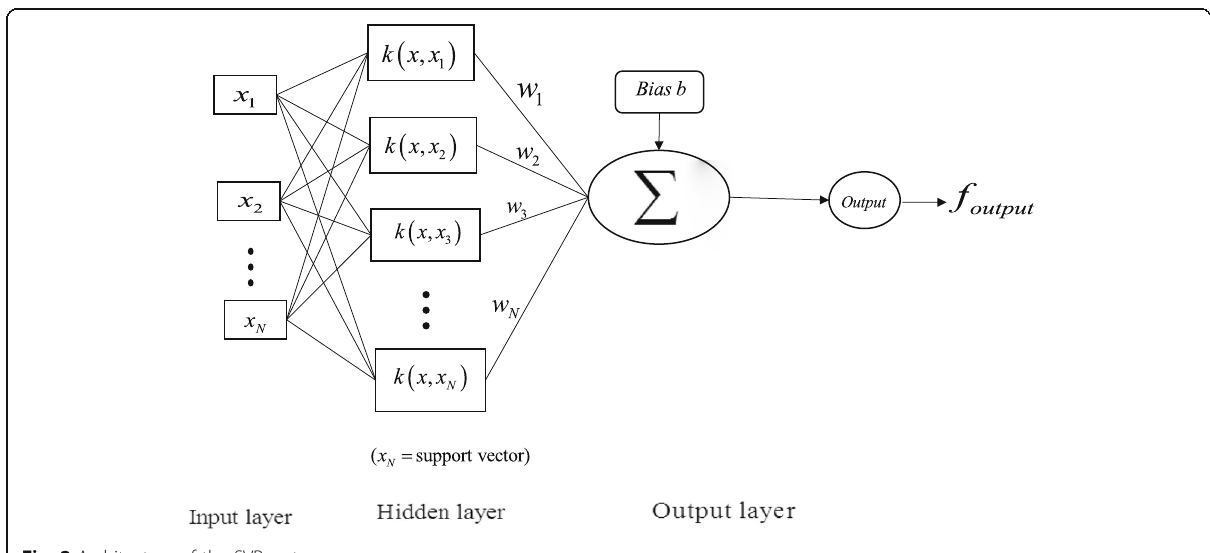
Fig. 2 Architecture of the SVR